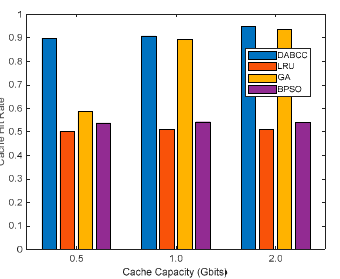
Figure 6. Cache hit rate under different cache capacities.